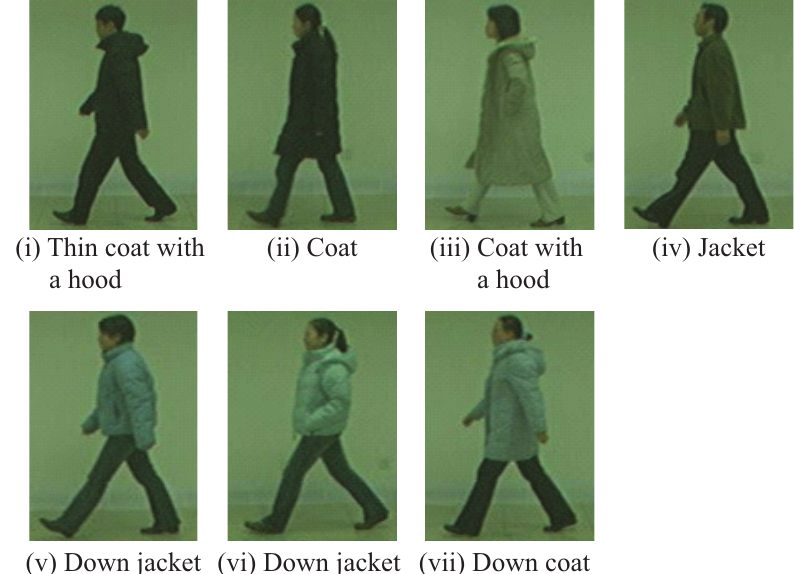
Figure 12. Example images of each category